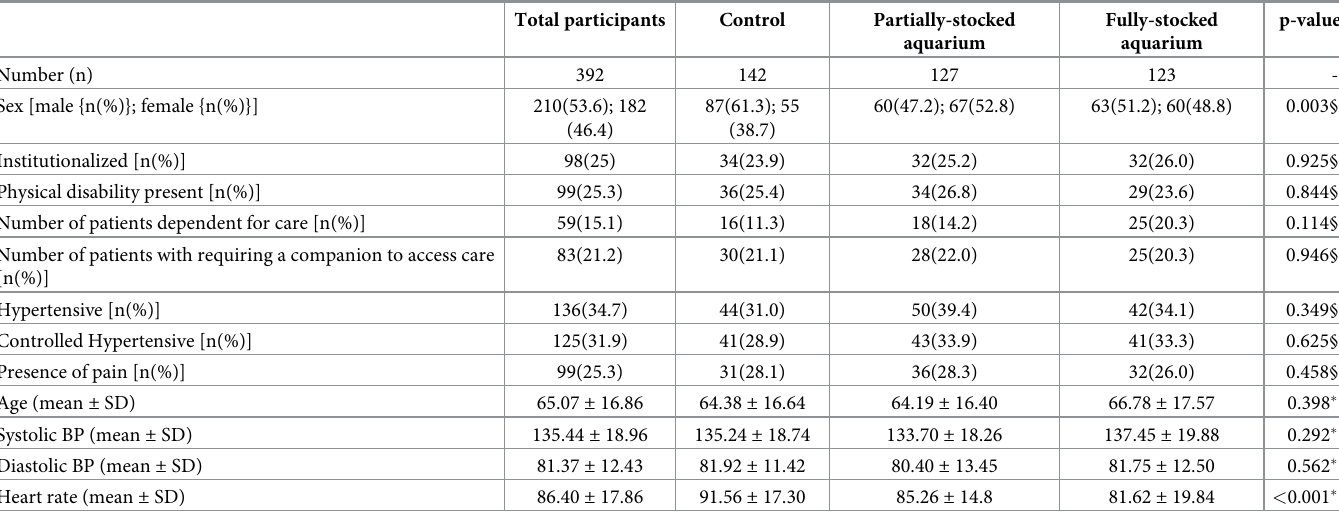
Table 2. Baseline demographics of the